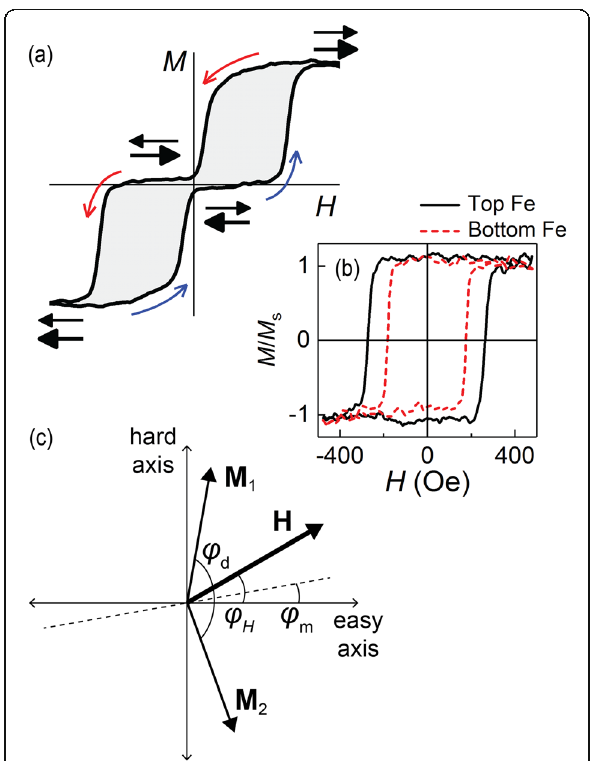
Fig. 2 a Typical in-plane magnetization curve, M ( H ), measured by MOKE for Fe/sp2/Fe multilayers with antiferromagnetic interlayer coupling. Curved arrows show direction of field sweep; horizontal arrows denote mutual alignment of Fe magnetic moments. b MOKE M ( H ) loops for reference Fe(2)/Cr(10) (bottom Fe) and Cr(10)/Fe(2) (top Fe) bilayers. c Reference-frame schematic of in-plane M 1 , M 2 , and H , with respect to easy axis of twofold magnetic anisotropy of a